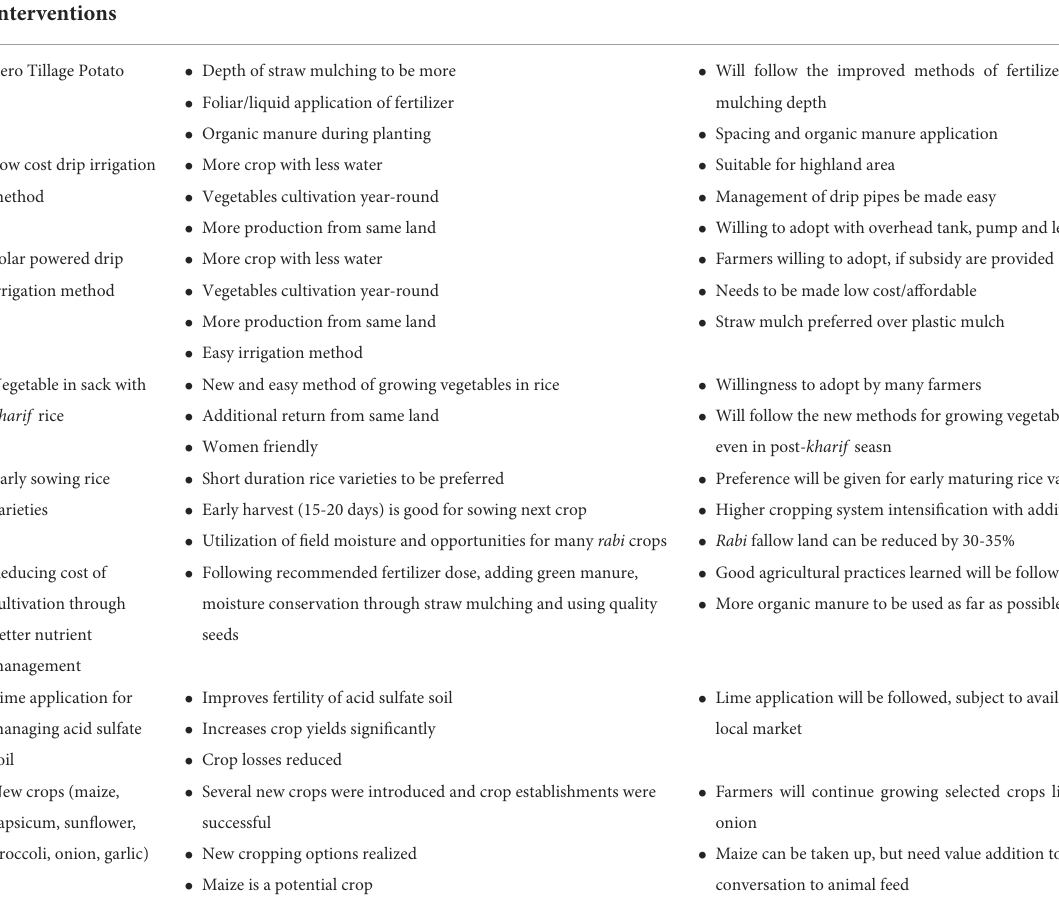
TABLE 5 New technical knowledge acquired and likely change over the existing agricultural practices.